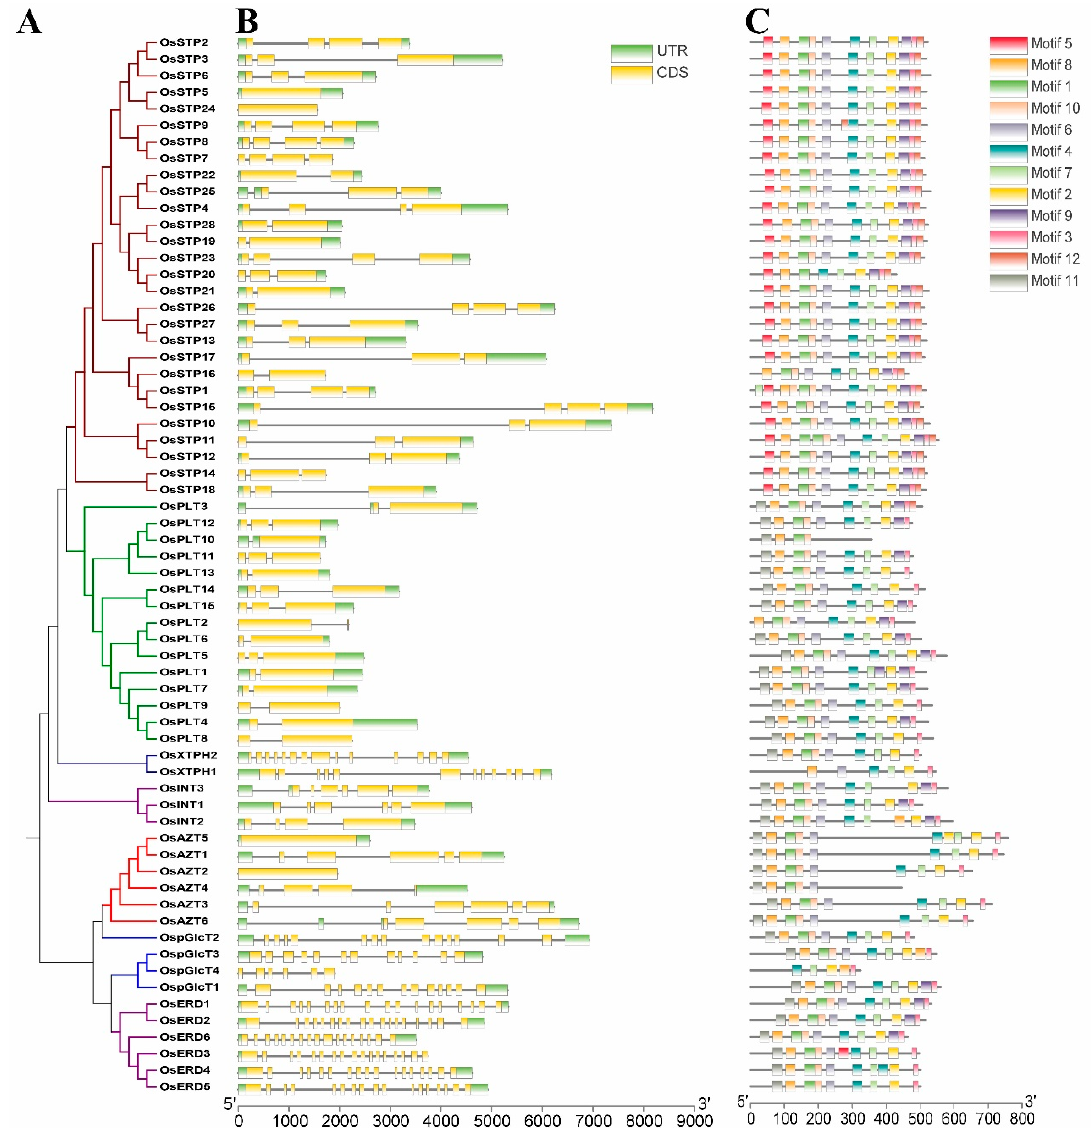
Figure 4. Phylogenetic tree ( A ), exon/intron structure ( B ), and motif compositions ( C ) of the monosaccharide transporter (MST) genes in rice. A: The Neighbor-Joining (NJ)-Phylogenetic trees are made in the same method with Figure 1B,C: The widths of grey bars at the bottom display relative lengths of genes and proteins. Green boxes and grey lines in B represent exons and introns, respectively. Different boxes in C represent different motifs.